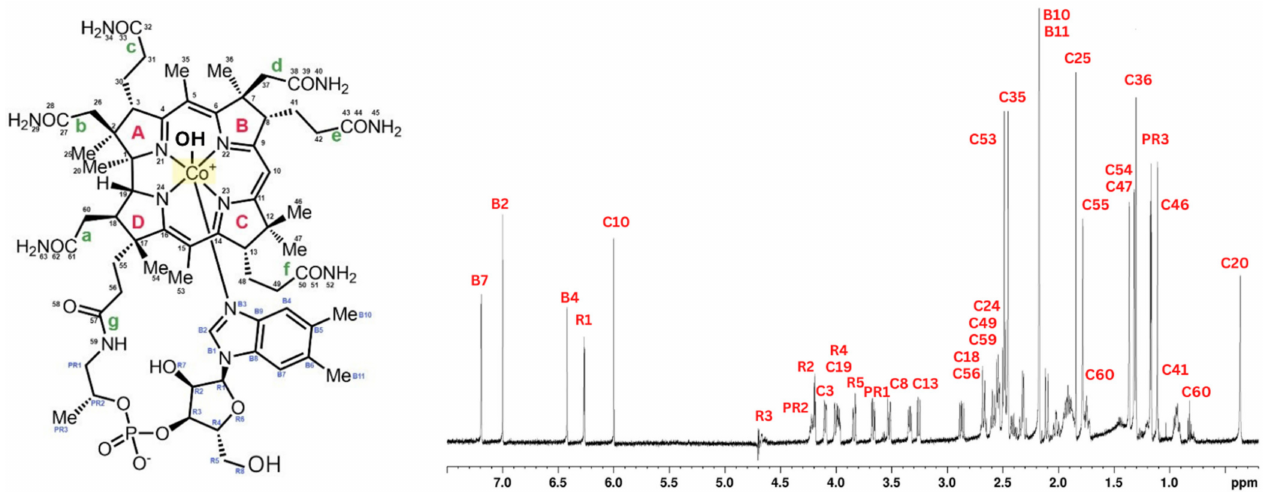
Figure 2. Molecular formula of aqua cobalamin ( left ). 1 H NMR spectrum of aqua cobalamin and identification of all proton peaks ( right